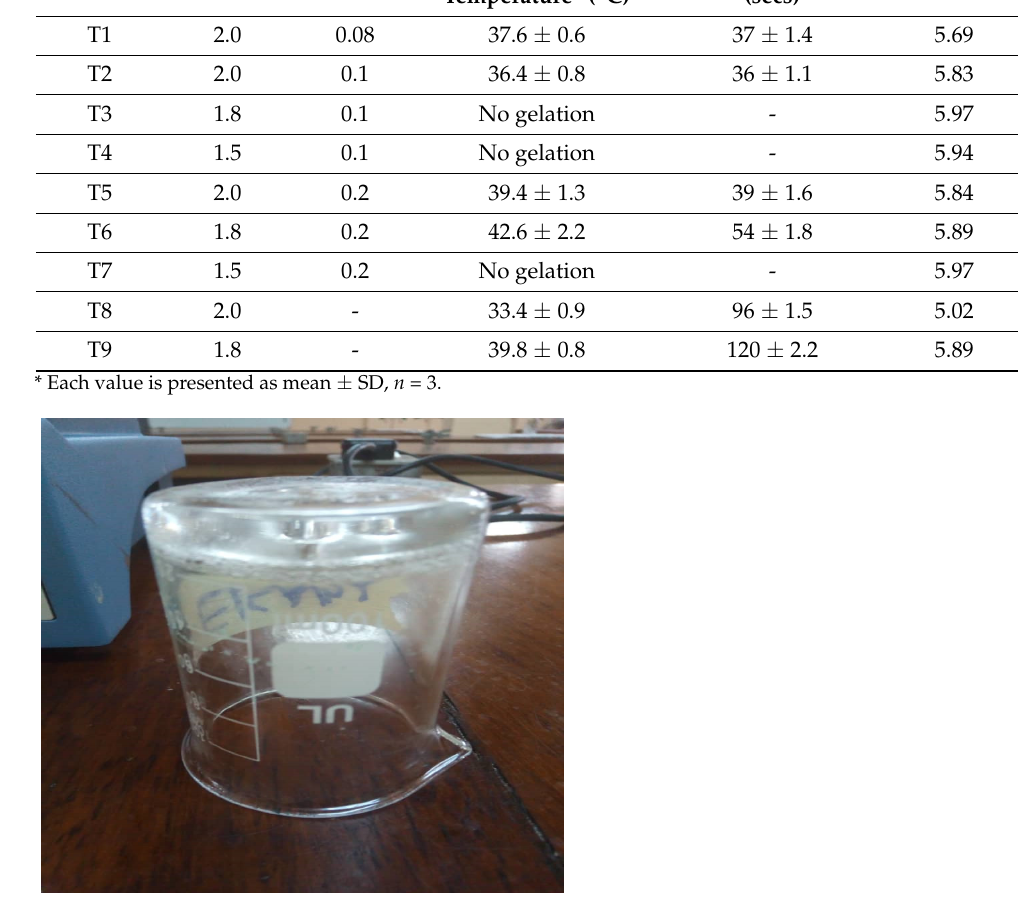
Figure 3. Thermosensitive gel, showing gelation at 36.4 o C. Table 3. Composition of a 10mL thermosensitive gel and characterization results. Table 4. Characterization for thermosensitive gel containing maraviroc and tenofovir